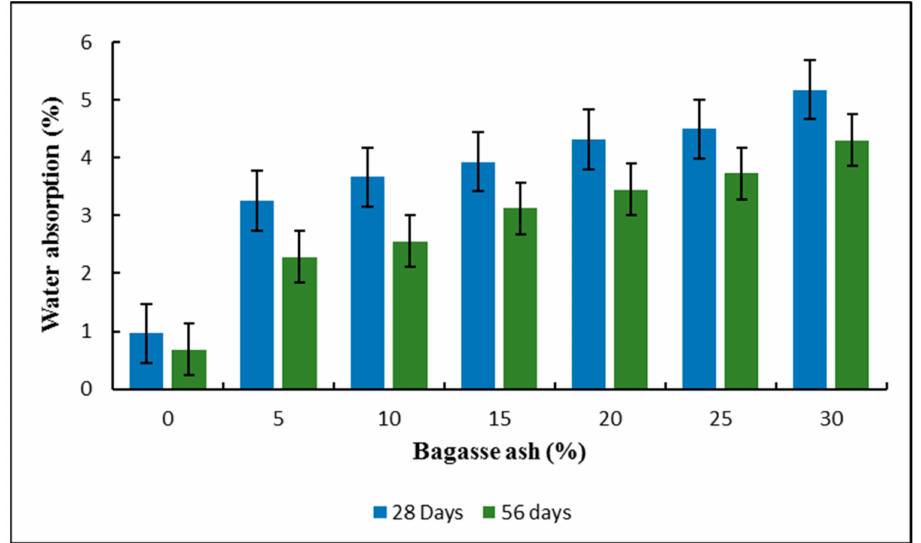
Figure 13. Water absorption of BA-OPC